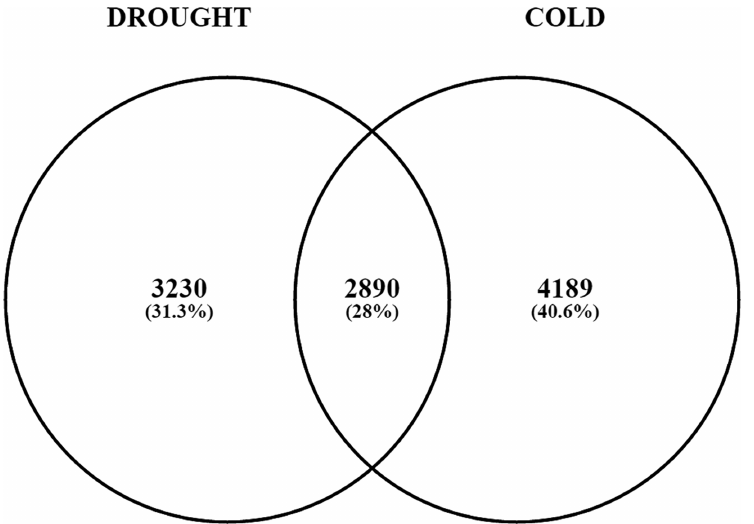
Fig 2. Number of unique and common differentially expressed genes (DEGs) found in A . thaliana under cold and drought stress. Total number of genes is shown in bold, below which are the percentages of